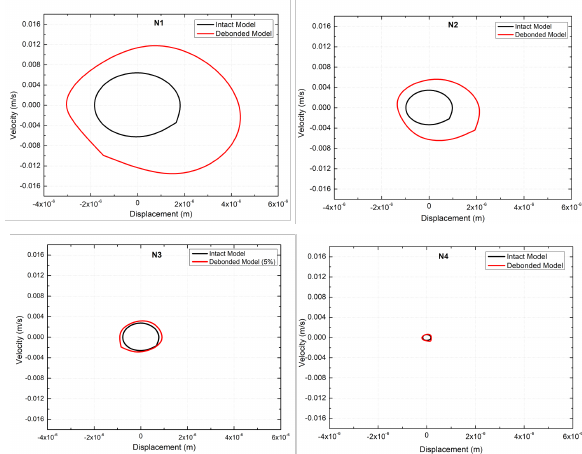
Figure 11: Comparison of phase portrait calculated at different measurement points at frequency ratio η =1/2.